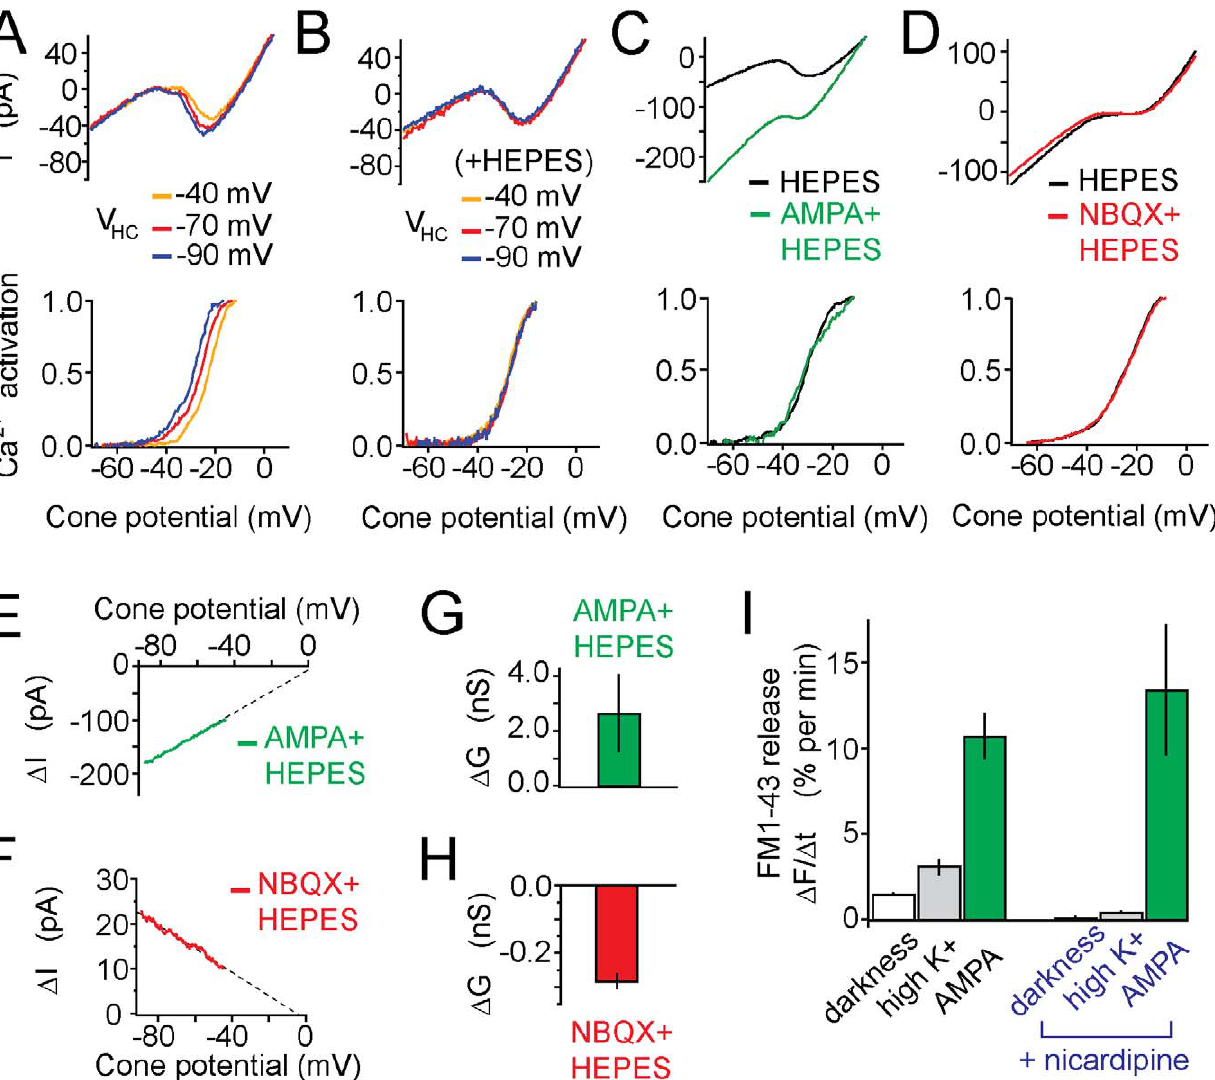
Figure 6. Ionic currents in cones modulated by negative and positive feedback. (A) Changing the voltage of an HC (V HC ) shifts the activation of the voltage-gated Ca 2 + current (I Ca ) in a cone, indicative of negative feedback. Data for (A) and (B) were from simultaneous patch clamp recordings from a synaptically connected HC and a cone in a slice from salamander retina. Top: Current-voltage (I-V) curves at three different values of V HC . Bottom: I Ca activation curves derived from these I-V curves (see Methods). I-V curves were generated by ramp depolarizations from 2 90 to 0 mV (0.5 mV/ms). I Ca activation curves were obtained by subtracting the linear leak current from the total membrane current during the ramp. The resulting leak-subtracted I Ca was normalized to the maximal I Ca and plotted only over the voltage range where channels are activating (e.g., from 2 70 to 2 20 mV). Data are reported as mean 6 SEM. (B) Same as (A), except with HEPES (10 mM) added to bath solution to block negative feedback. (C) AMPA (20 m M) elicits a voltage-independent conductance that increases with hyperpolarization. HEPES (10 mM) was added to the bath solution to block negative feedback. Traces represent average currents from five cones. Data for panels (C–H) were from patch clamp recordings from cones in flat-mounted salamander retinas. (D) NBQX (10 m M) reduces the voltage-independent conductance. HEPES was again added to the bath solution to block negative feedback. Traces represent average currents from 13 cones. (E, F) I-V curve of the voltage-independent conductance modulated by AMPA or NBQX. Difference currents were calculated from data in panels (C) and (D). Dashed lines are extrapolated linear fits to show reversal potentials. (G, H) Quantification of the average effect of AMPA ( n =5) or NBQX ( n =13) on the voltage-independent conductance. (I) L-type Ca 2 + channels are not required for positive feedback. Left: The FM1-43 release rate in darkness is accelerated by adding high K + ( n =9) or 20 m M AMPA ( n =16). Addition of nicardipine (100 m M) suppressed release in darkness ( n =7) and in high K + ( n =3) but not in AMPA ( n =4).